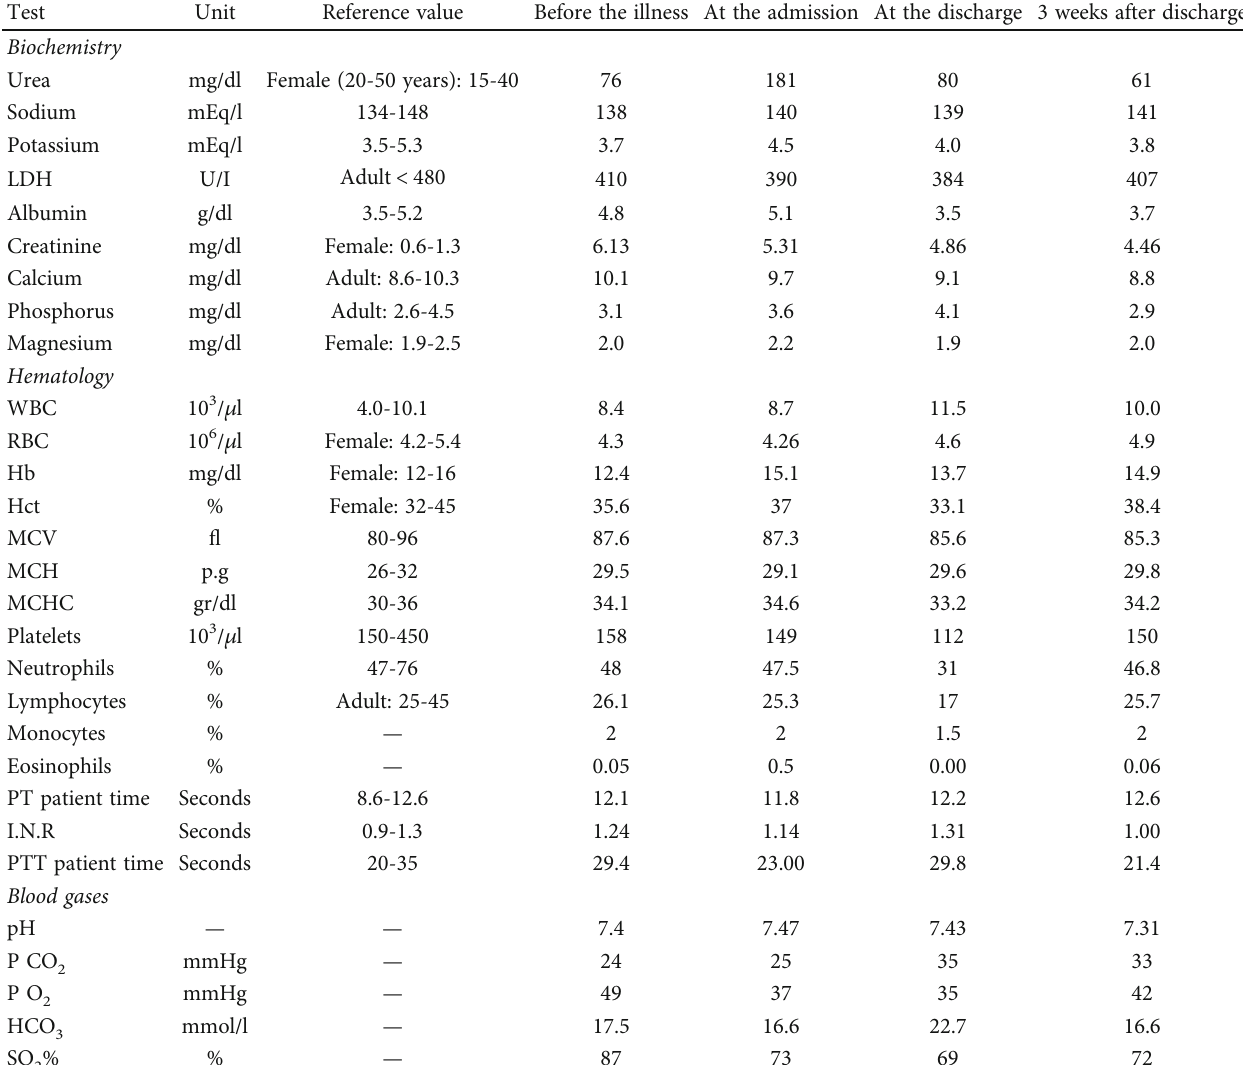
Table 1: Clinical laboratory